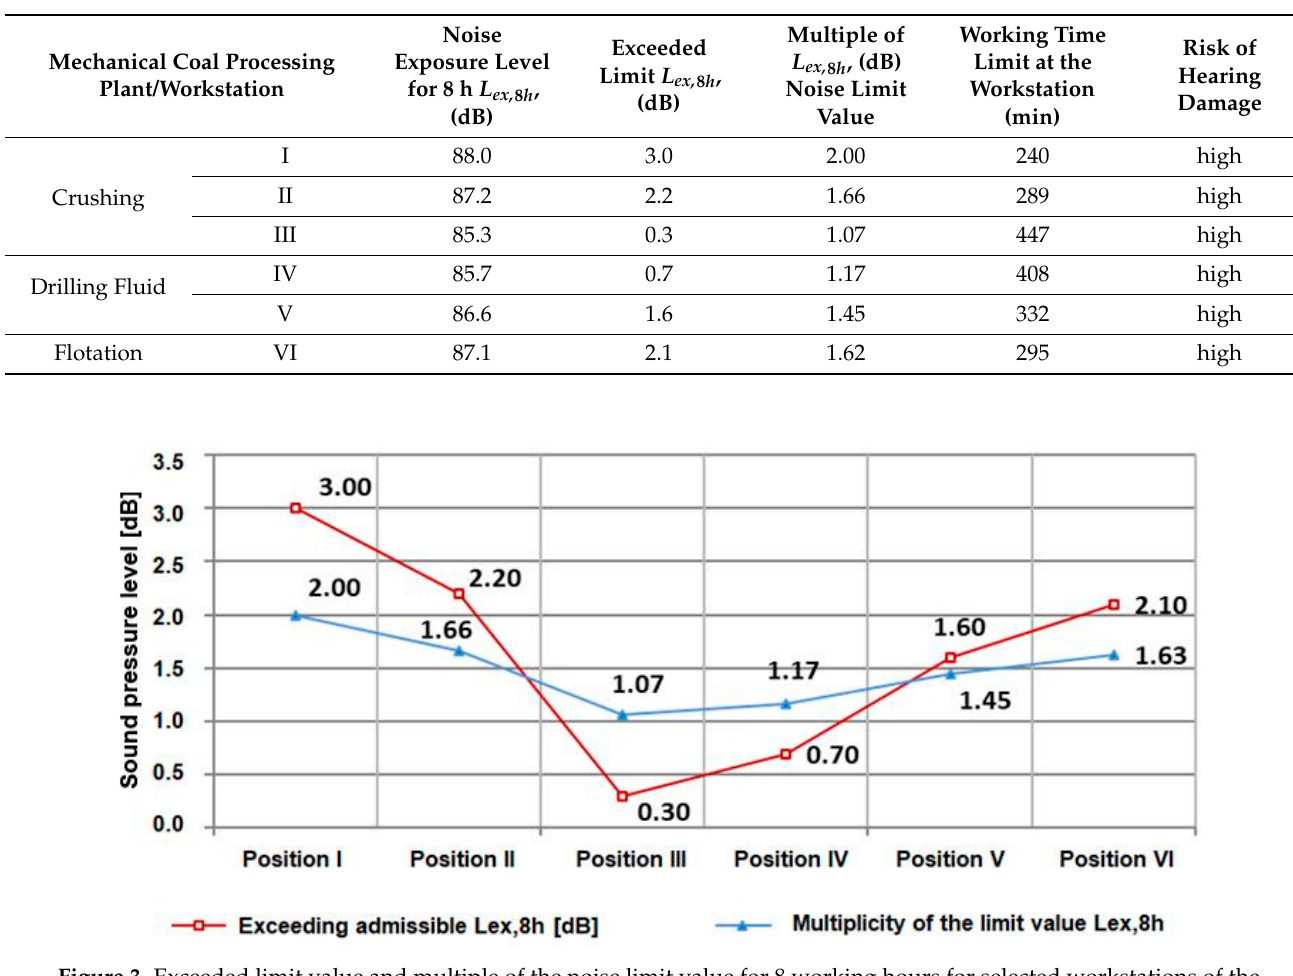
Figure 3. Exceeded limit value and multiple of the noise limit value for 8 working hours for selected workstations of the mechanical coal processing plant.